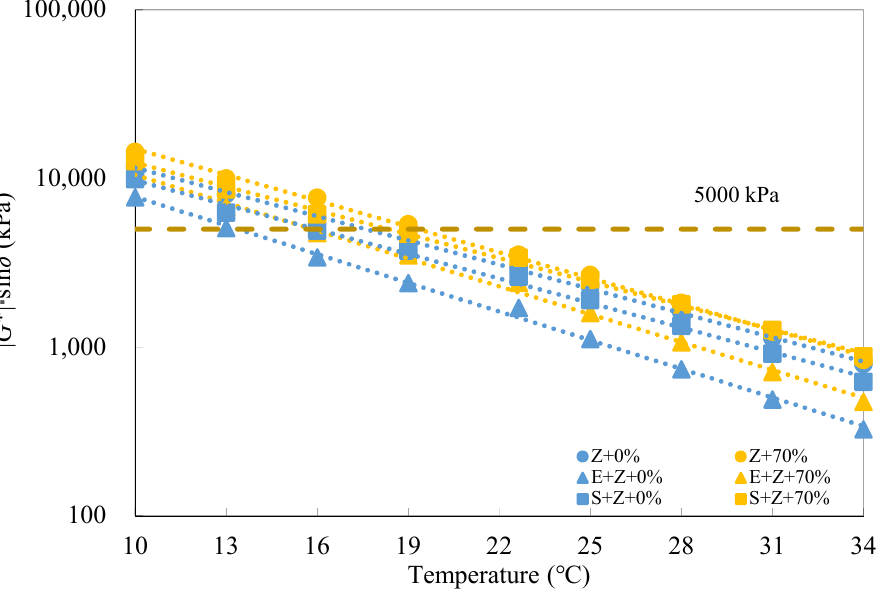
Figure 11. Fatigue parameter test results of the warm-mix recycled binders at different testing temperatures under the long-term aged condition.